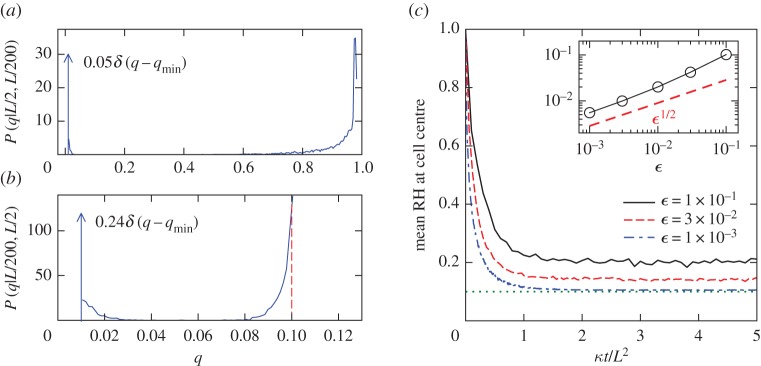
(a) Conditional PDF P(q|x,y) of specific humidity inside the source boundary layer at (x,y)=(L/2,L/200) for ϵ=3×10−2. The PDF consists of a continuous part (solid line) and a dry spike indicated by an arrow at q=qmin. (b) As in (a) but for (x,y)=(L/200,L/2) inside the condensation boundary layer. The dashed line marks the value of qs(L/2). (c) Mean relative humidity (RH) for parcels in the neighbourhood (within a distance of L/80) of the cell centre as a function of time t. For small ϵ, its long-time value RH ∞ctr approaches the minimum attainable value RH minctr=qmin/qs(L/2)=0.1 (dotted line). The inset shows the difference RH ∞ctr− RH minctr scaling as ϵ1/2. (Online version in colour.)